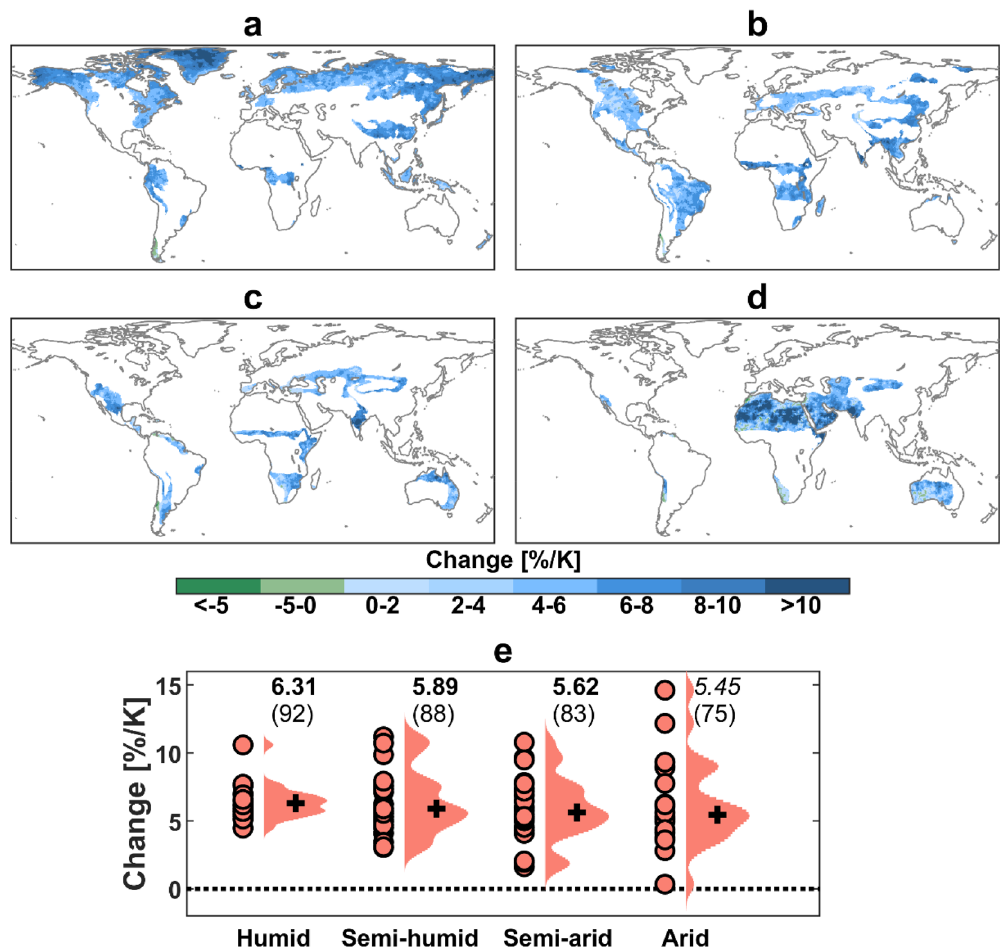
Figure 2. Changes (%) in 1-in-30-year extreme precipitation intensity per K global warming in 2070–2099 under RCP8.5, compared with 1971–2000. ( a – d ) Spatial distribution of ensemble median changes in ( a ) humid, ( b ) semi-humid, ( c ) semi-arid and ( d ) arid regions. ( e ) Changes per climate regime based on individual models (salmon dots). For each violin, ensemble median is shown by black cross. The numbers on top of the violins (top row) indicate ensemble median and those in bold face and italic denote significant changes at the 95% and 90% confidence levels, respectively. The numbers in brackets indicate the percentage of experiments that agree on the sign of change (robustness). The maps were generated using the MATLAB mapping toolbox 65 (URL https :// www.mathw orks.com/produ cts/mappi